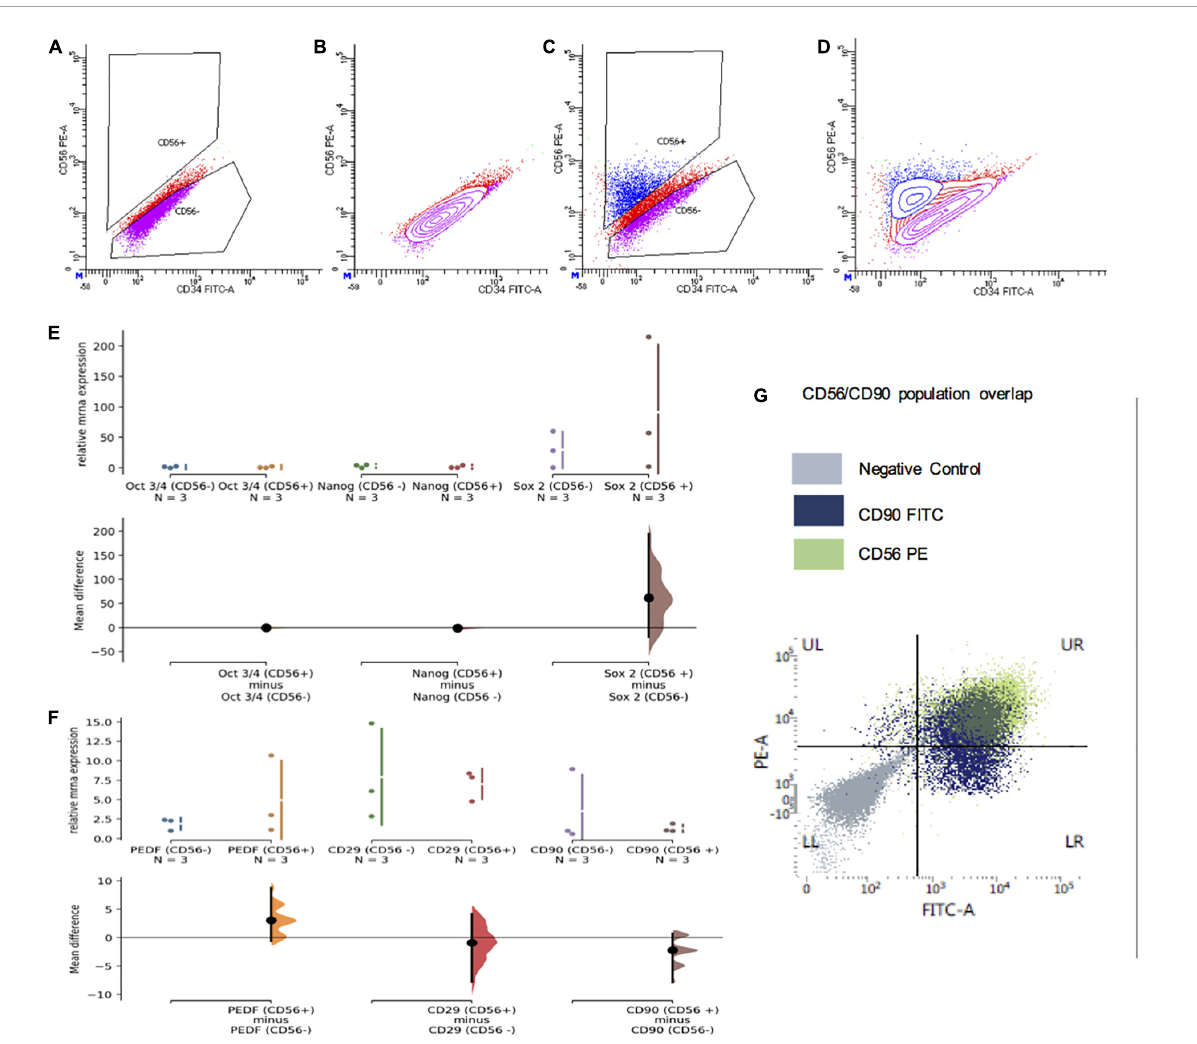
FIGURE6 CD56+ subpopulations of primary human DPSC are also predominantly mesenchymal. (A–D) Representative flow cytometry plots demonstrating gating of CD56 negative and positive cells which was used to segregate primary DPSC into CD56+ and CD56- cells. (A,B) Scatter plots of primary DPSC cells stained with secondary (PE) only negative controls. (C,D) Scatter plots of cells stained with PE-conjugated CD56 antibody. (E) There was no significant difference in relative mRNA expression of pluripotency markers Oct 3/4, Nanog and Sox2 in CD56+ compared to CD56˝U cells. (F) There was no significant difference in relative mRNA expression of mesenchymal markers PEDF/CD29 and CD90 in CD56+ compared to CD56˝U cells. (G) FACS scatter plot showing significant overlap of CD56+ (green) and CD90+ (blue) cells in UR quadrant with most of the CD56+ cells showing positivity for CD90 as